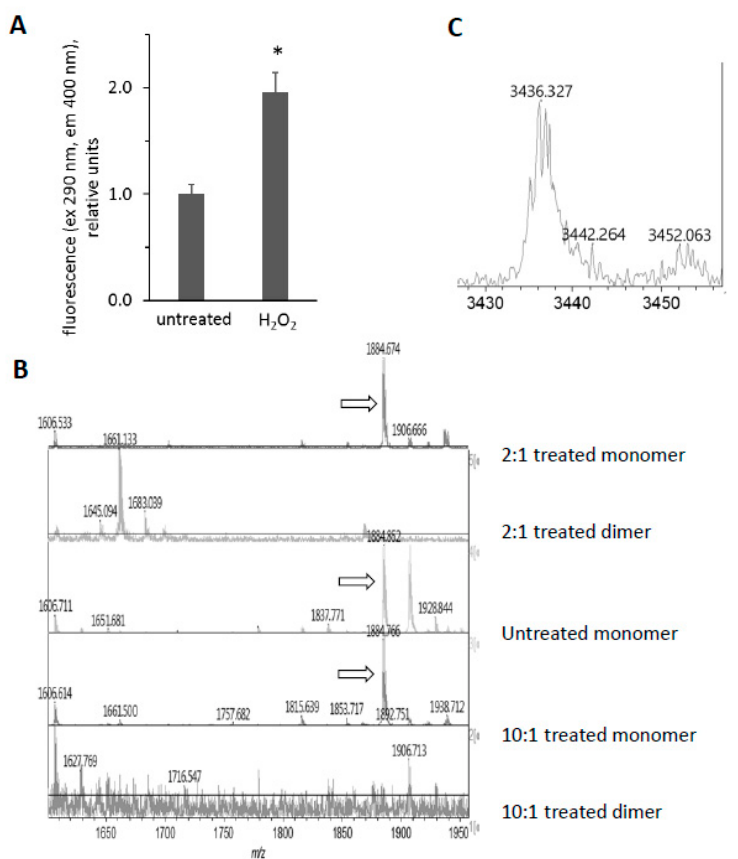
Figure 8. Reaction of horse metMb with H 2 O 2 results in dityrosine formation. ( A ) Fluorescence of metMb was measured before and after oxidation with H 2 O 2 using excitation and emission wavelengths of 290 nm and 400 nm, respectively. * p ≤ 0.005 compared to untreated, n = 6/group. ( B ) MALDI-TOF analysis of metMb tryptic digests revealed that the tryptic peptide containing tyrosine 103 (1885 m/z ) was absent in the H 2 O 2 -treated dimer. From bottom: dimer from 222 µM Mb reacted with 2.2 mM H 2 O 2 ; monomer from 222 µM Mb reacted with 2.2 mM H 2 O 2 ; untreated monomer; 222 µM Mb dimer reacted with 444 µM H 2 O 2 ; 222 µM Mb monomer reacted with 444 µM H 2 O 2 . Arrows indicate peaks for 1885 m/z . ( C ) MALDI-TOF analysis of oxidized metMb dimers indicate the presence